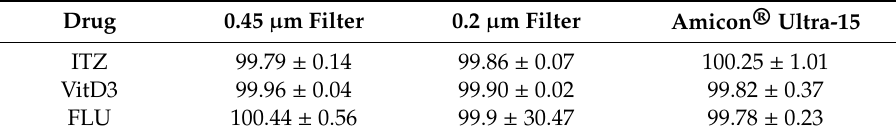
Table 4. Drug recovery (%) during filtration and centrifugal